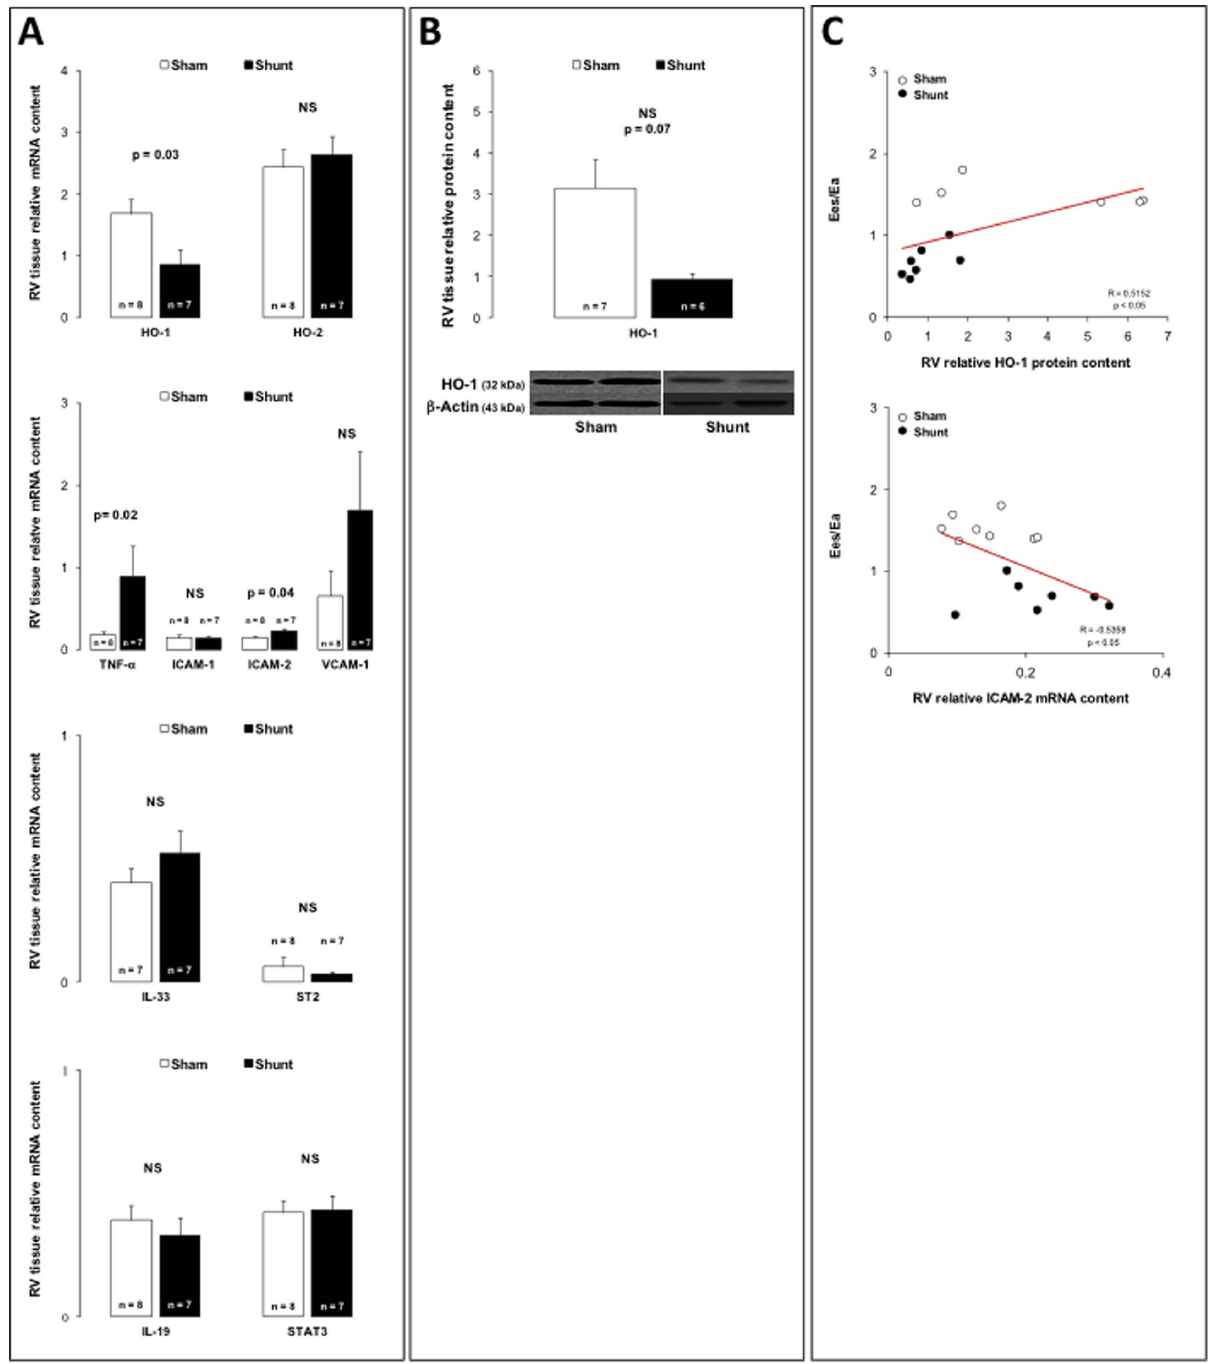
Figure 4. Panel A: Relative right ventricular (RV) tissue mRNA content for the heme-oxygenase(HO)-1 and -2, tumor necrosis factor(TNF)- a , intercellular adhesion molecule(ICAM)-1 and -2, vascular cell adhesion molecule(VCAM)-1, interleukin(IL)-33, interleukin 1 receptor-like 1 (ST2), interleukin(IL)-19 and signal transducer and activator of transcription(STAT)-3 in 6-month sham (white bars) and 6-month shunt (black bars) piglets. Relative right ventricular (RV) tissue protein content for the heme-oxygenase(HO)-1 in 6- month sham (white bars) and 6-month shunt (black bars) piglets. Correlation between Ees/Ea ratio and right ventricular (RV) protein content for heme-oxygenase (HO)-1 and right ventricular (RV) mRNA content for intercellular adhesion molecule (ICAM)-2. Values expressed as mean 6 SEM. doi:10.1371/journal.pone.0069470.g004 prevent the development of hypoxia-induced PH, associated with remodeling [41–42]. HO-1 mediates in vivo the protective effects reduced pulmonary inflammation (characterized by increased in monocrotaline-induced PH and in vitro the anti-proliferative macrophage activity and IL-10 expression [40])and vascular effects in smooth muscle cells of rapamycin [43]. In contrast,